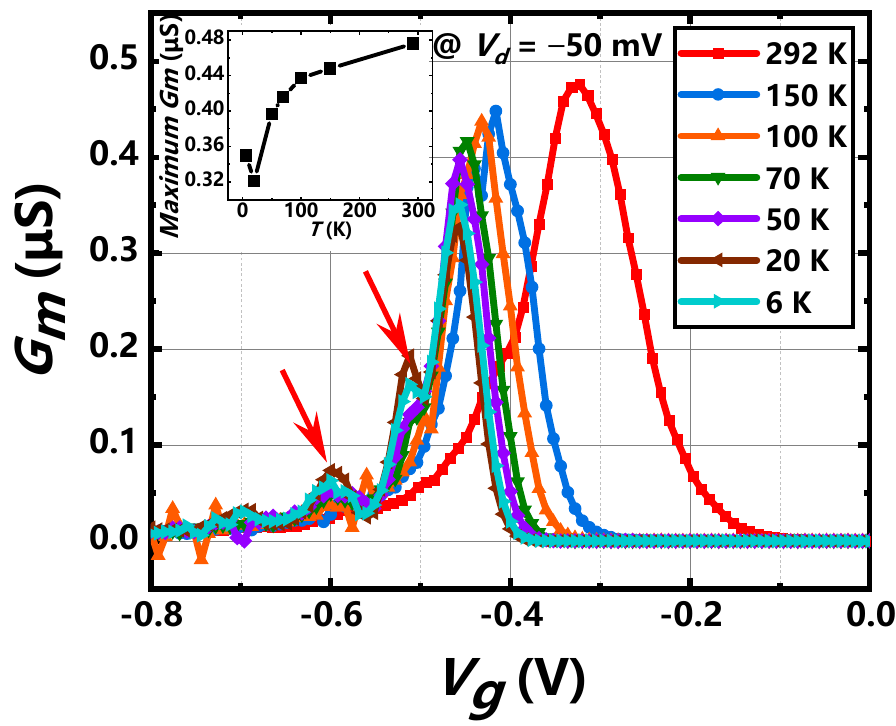
Figure 4. The extracted transconductance at bias of − 50 mV at different temperatures ranging from 6 K to 292 K. Inset: temperature dependence of maximum G m .